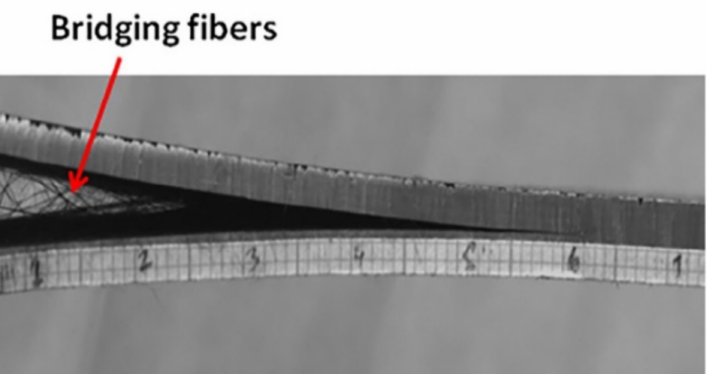
Figure 5. Fiber bridging mechanism of unidirectional laminates. Reproduced from ref.